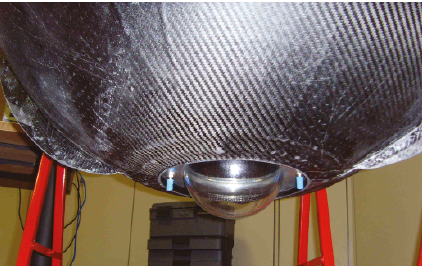
Figure 8: Exterior of lower payload.